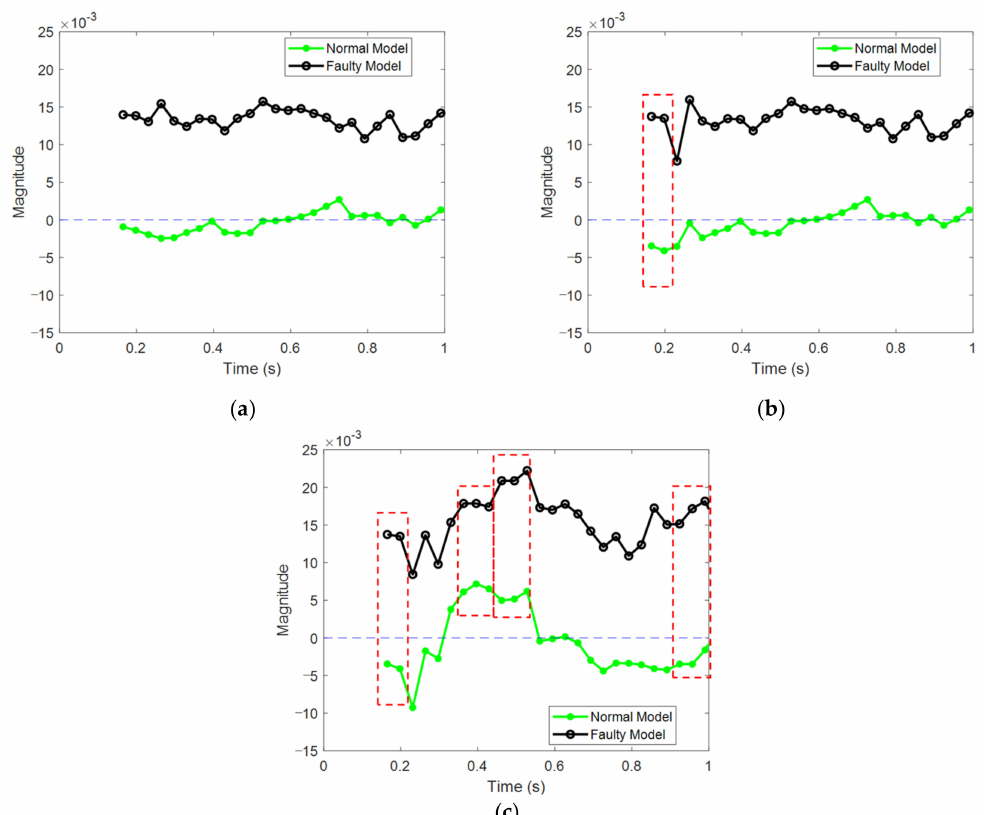
Figure 11. The result of the proposed method to the signal models. The difference between the magnitude at rotational frequency and the baseline lower frequencies in short time envelope spectrum: ( a ) case without impulsive noises; ( b ) case in the presence of impulsive noise at 0.1 s; ( c ) case in the presence of four impulsive noises at 0.1, 0.4, 0.5, and 0.8